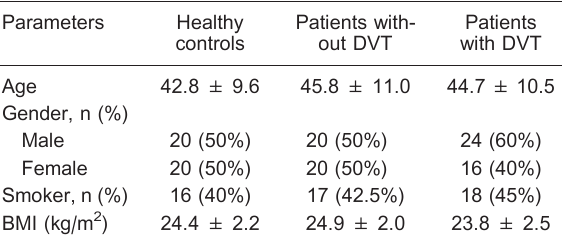
Table 1. Demographic and baseline characteristics of patients with and without deep venous thrombosis (DVT) after surgery for an abdominal malignancy and healthy controls.